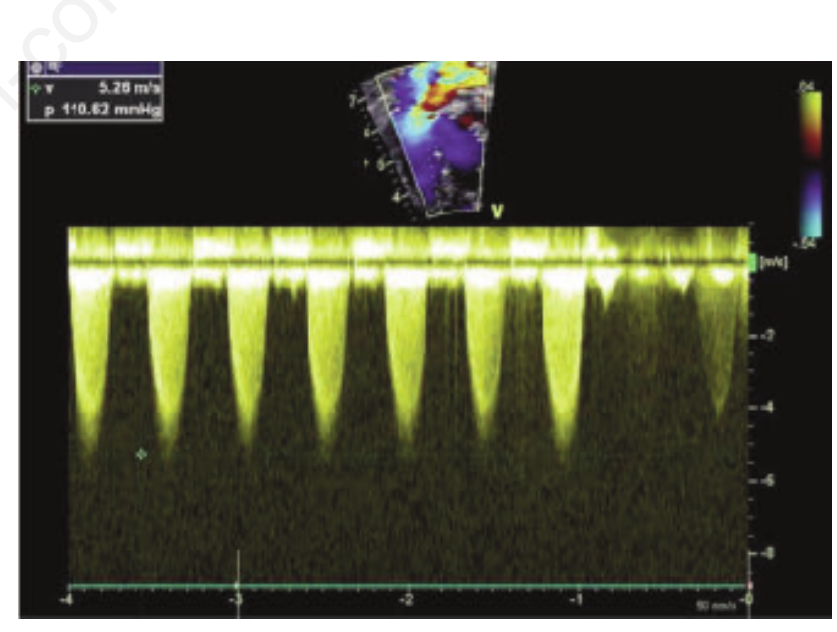
Figure 2. Doppler study of severe pulmonary valve stenosis in a patient with Noonan